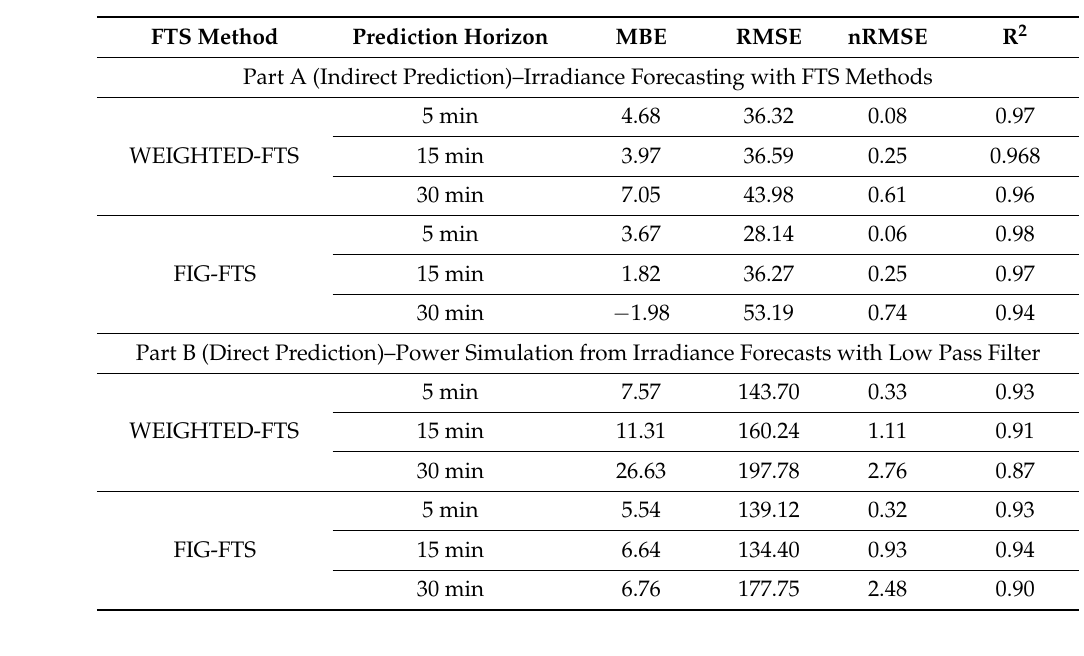
Table 7. Statistical metrics of prediction errors.